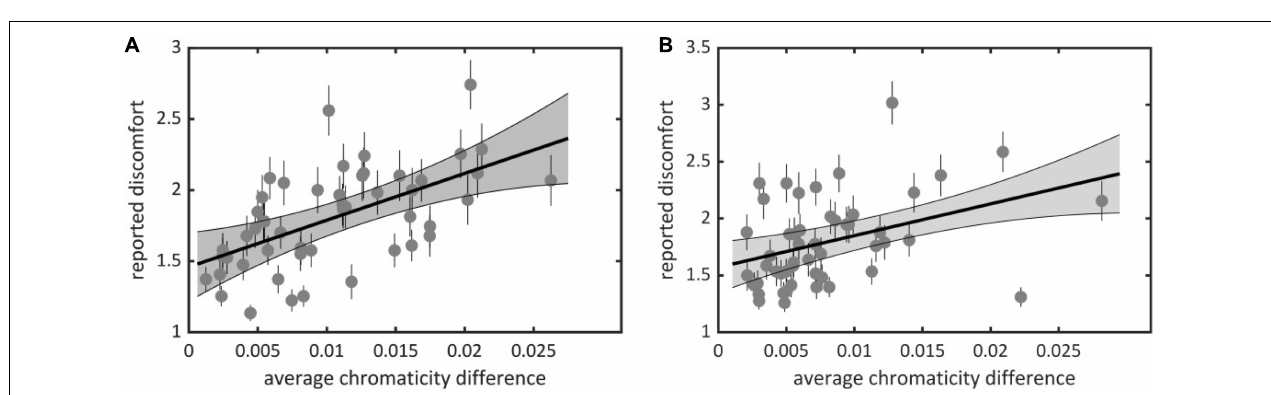
FIGURE 2 | Average reported discomfort against average chromaticity difference for (A) Experiment 1 (Set 1) and (B) Experiment 2 (Set 2). Each point represents an image in one of the sets with (x-coordinate) its average chromaticity difference and (y-coordinate) reported visual discomfort averaged over all observers. Plain lines represent best linear fit, the gray area represents the 95% confidence interval for the regression line and the small lines represent the standard error of the mean (see Supplementary Material for individual data).